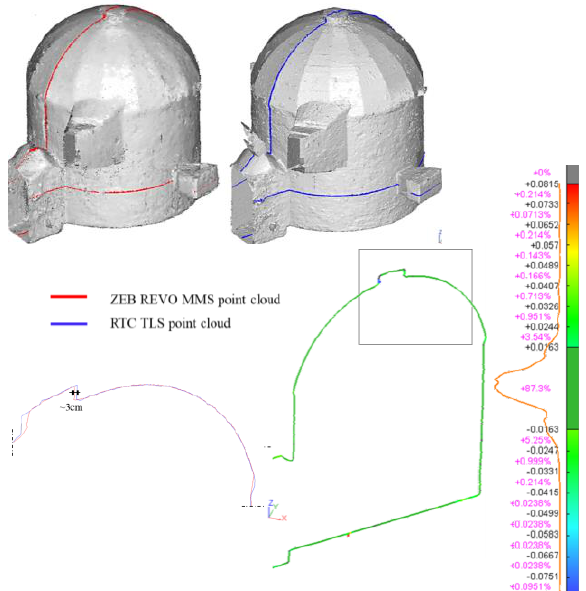
Figure 7. The Zeb (left) and the RTC Leica (right) clouds and its features. Comparison of a sample profile section defining the accessible level of